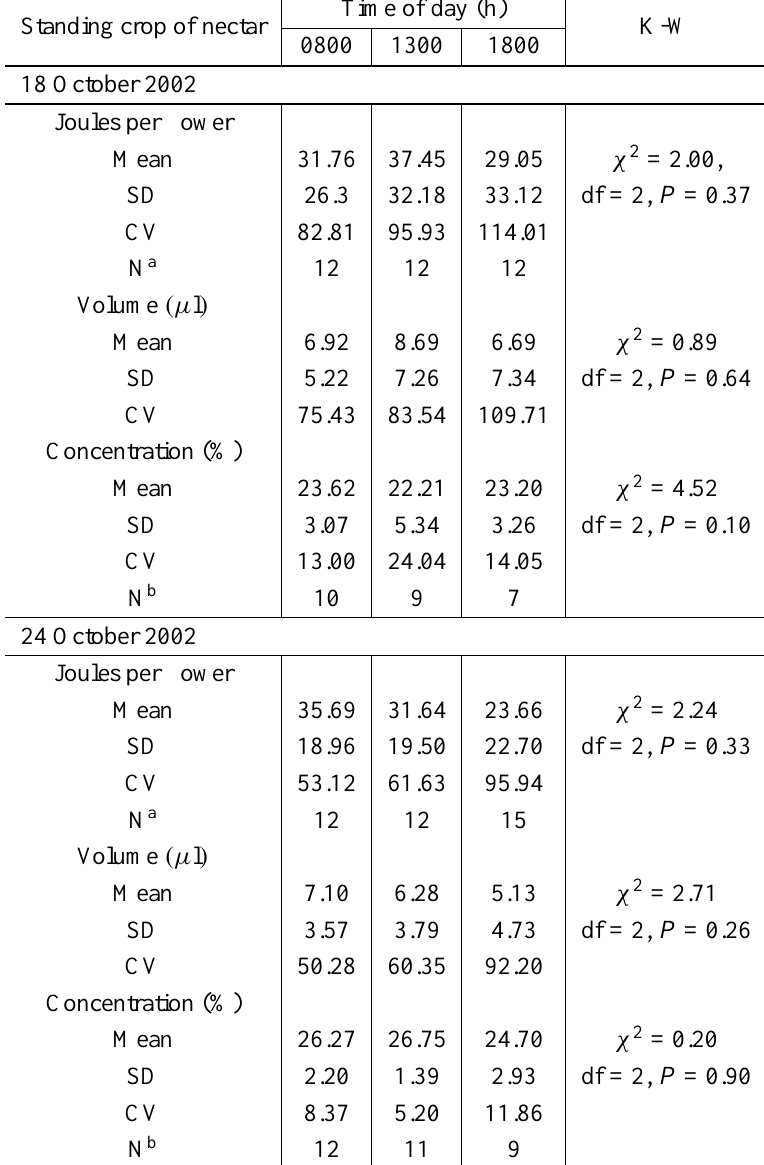
Nectar standing crop in Palicourea crocea flowers in the Upper Paraná River floodplain at different times of day. SD: standard deviation; CV: coefficient of variation (%). K-W: results of Kruskal-Wallis (χ 2 ) comparisons. Standing crop of nectar